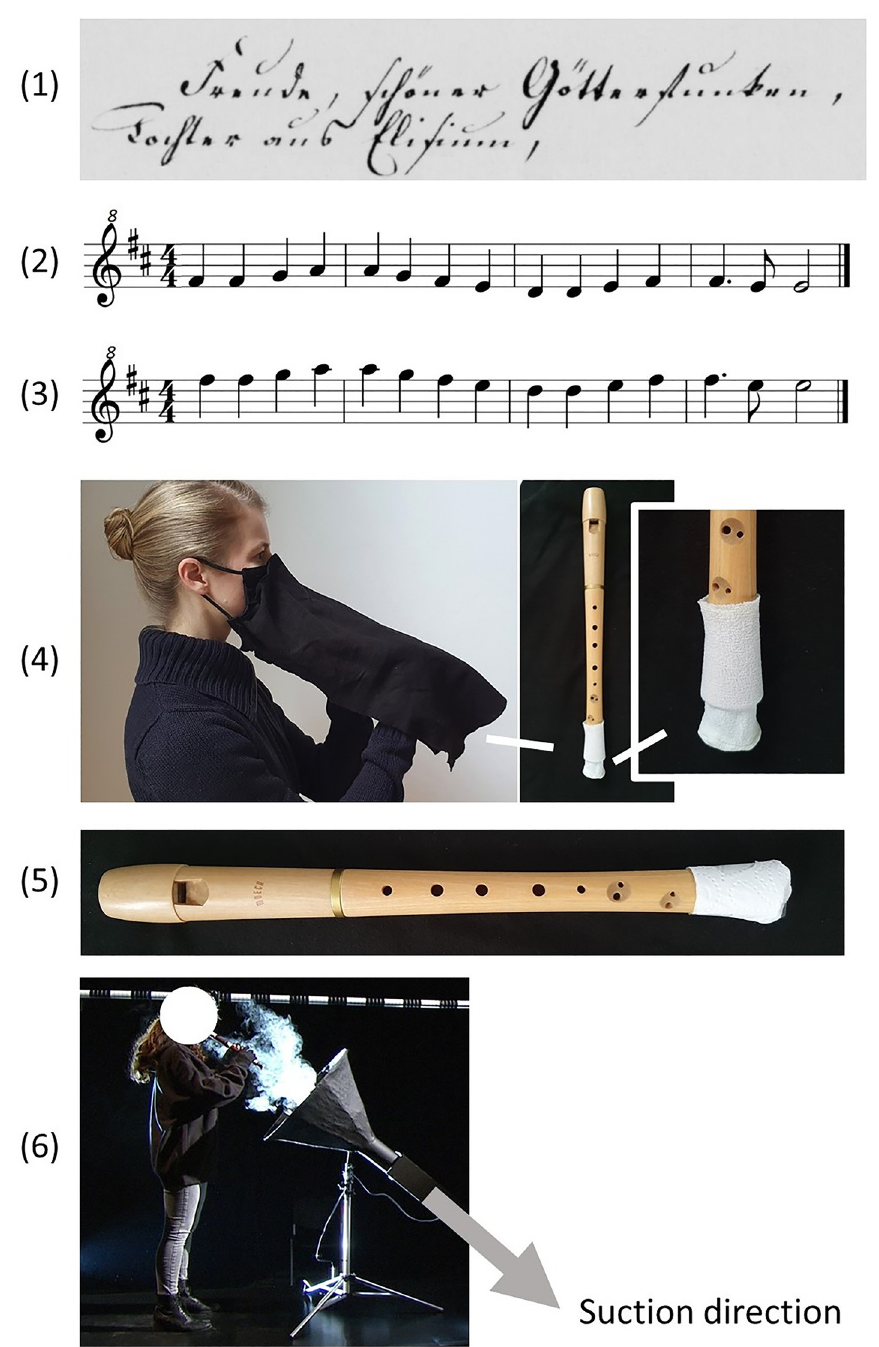
Fig 1. All performed tasks. (1) Reciting the excerpt from Friedrich Schiller’s “Ode to Joy” [23]. (2) and (3) playing the melody. The potential protection devices: (4) cloth mask and bell hole cover, (5) paper towel, (6) suction funnel.